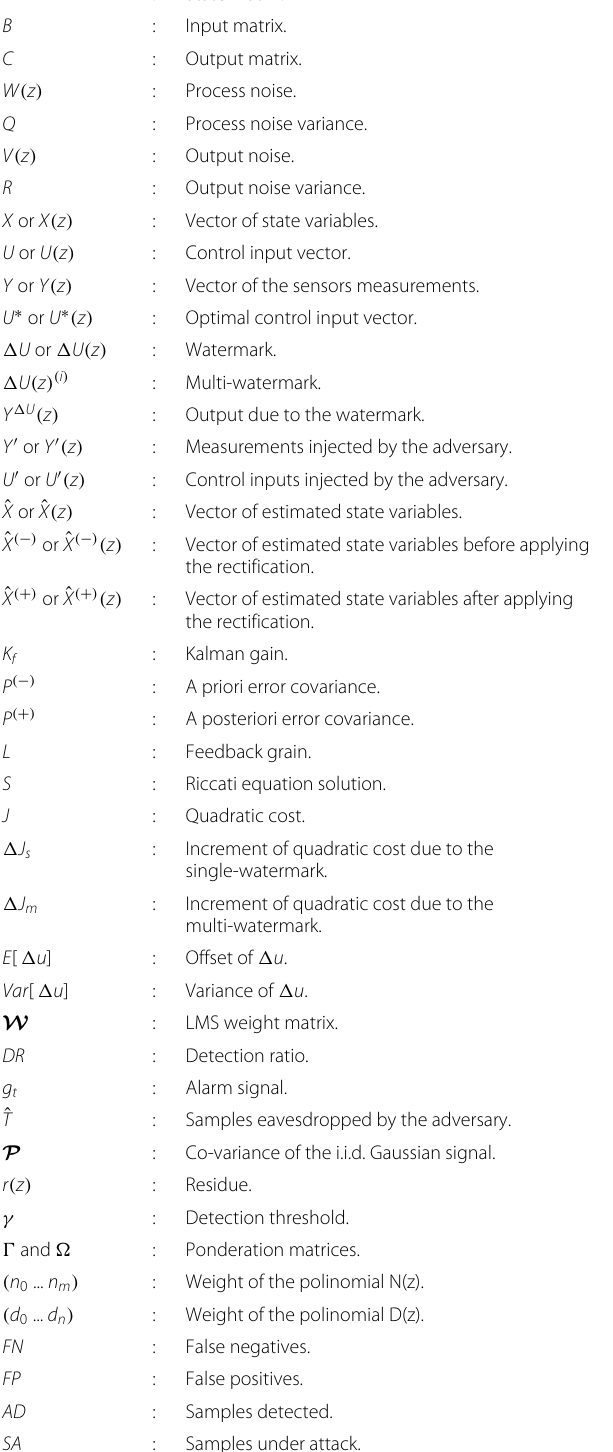
Table 1 Notations used in this